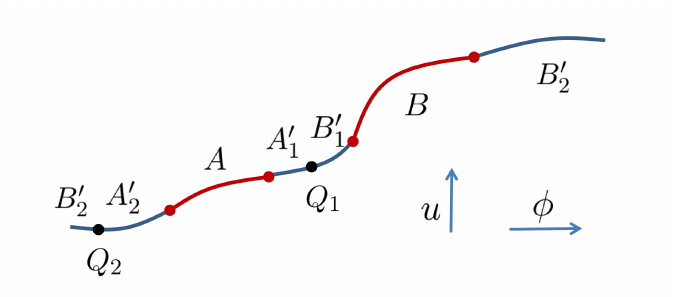
Figure 9: The non-adjacent intervals A : { ( u B : { ( u